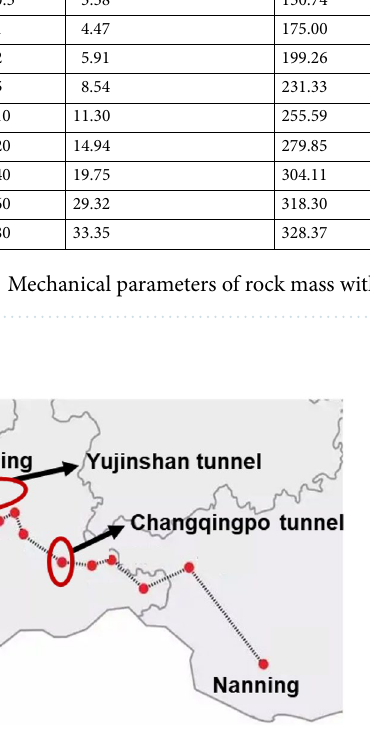
Figure 8. The relative location of Changqingpo tunnel and Yujinshan tunnel.